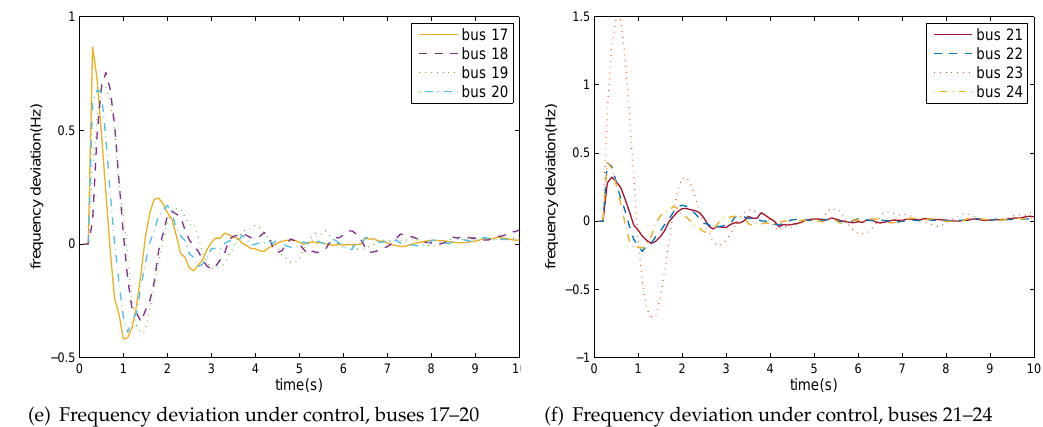
Figure 6. Frequency deviation of IEEE 24 bus system under control.